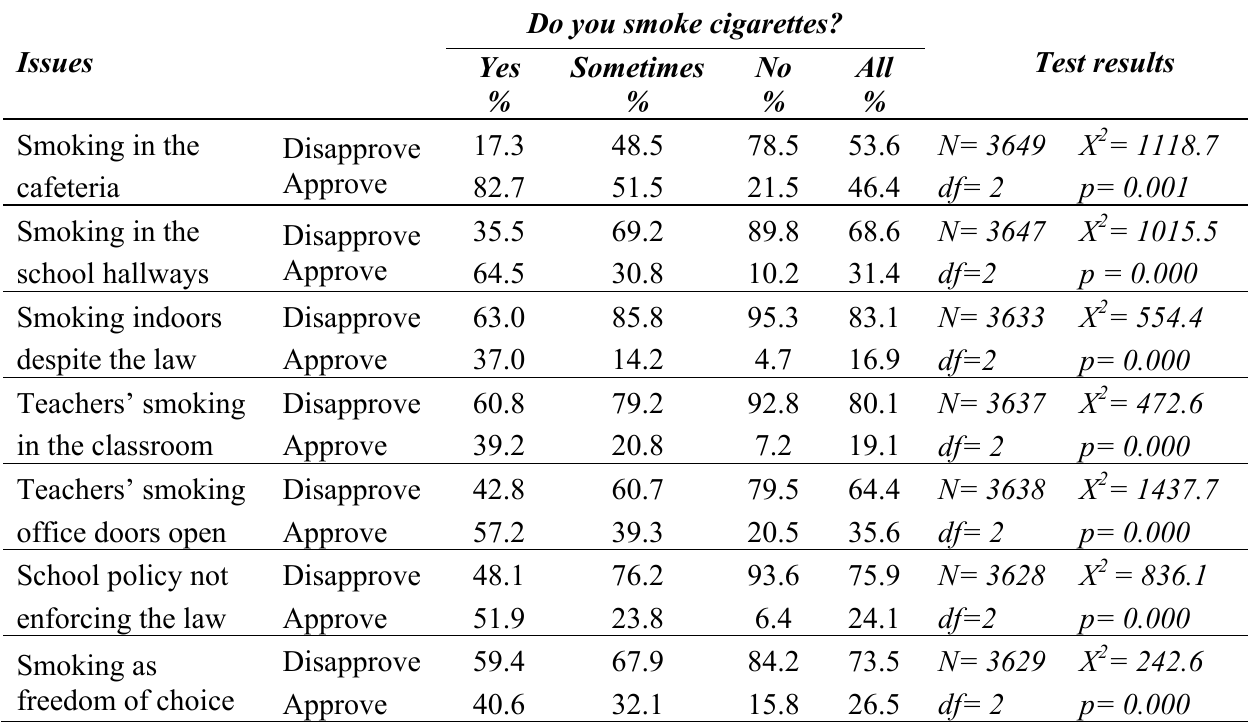
Table 2. Distribution of responses according to cigarette